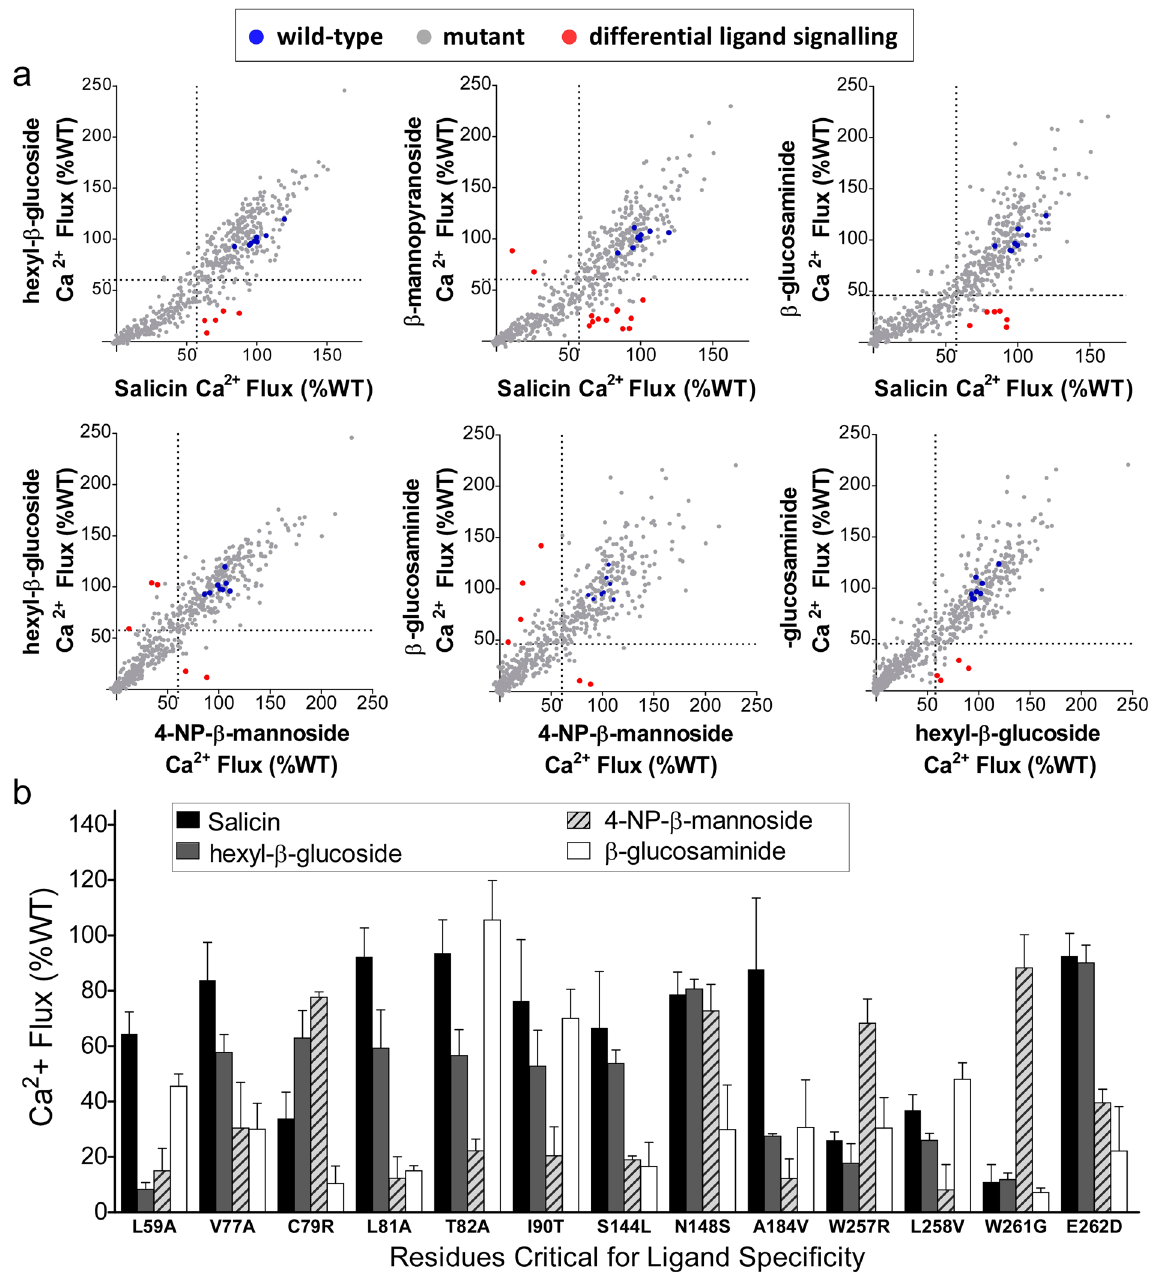
Figure 3. Identification of ligand-specific structures. ( a) Each of the four TAS2R16 ligands selected was tested against the entire TAS2R16 mutation library (573 individual mutations, n = 2–3) and values derived for each are compared. Concentrations chosen for mutation library screening were approximately 2 to 3 times higher than the EC 50 value for each ligand to maximize the sensitivity of detecting decreases in signaling due to the mutation in each clone (3 mM salicin, 5 mM hexyl- β -glucoside, 1.6 mM 4-NP- β -mannoside, and 10 mM β -glucosaminide). Cutoffs of (100-3 * SD), derived from wild-type positive control wells for each ligand, were used to identify clones that showed high Ca 2 + flux for one ligand but low Ca 2 + flux for the other (57% for salicin, 58% for hexyl-glucoside, 53% for 4-NP- β -mannoside, and 46% for β -glucosaminide). Of these critical residues, mutants that signaled 2.5-fold higher or lower were identified as the most significant (shown in red). Average values obtained from wild-type controls for each ligand are shown in blue. (b) Ca 2 + flux activities are shown for clones expressing mutations that resulted in a ≥ 2.5-fold difference between Ca 2 + flux activities for any two